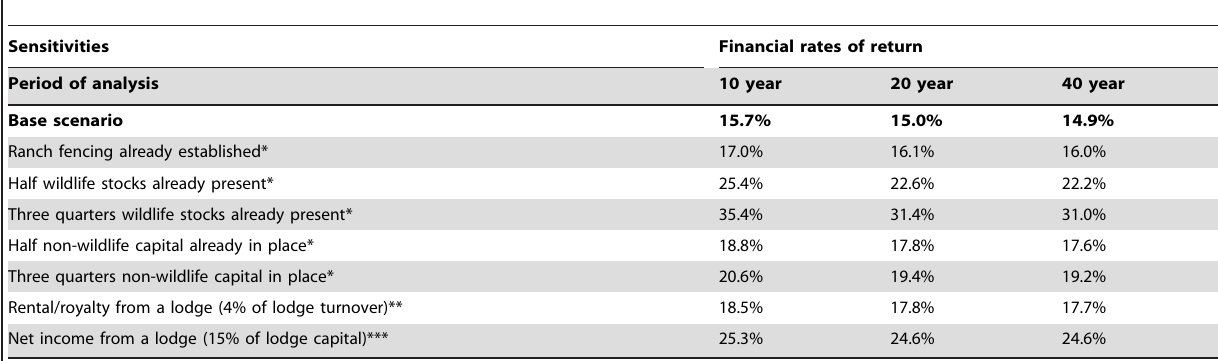
Table 6. Results of sensitivity analysis for the financial model for small-scale fenced game